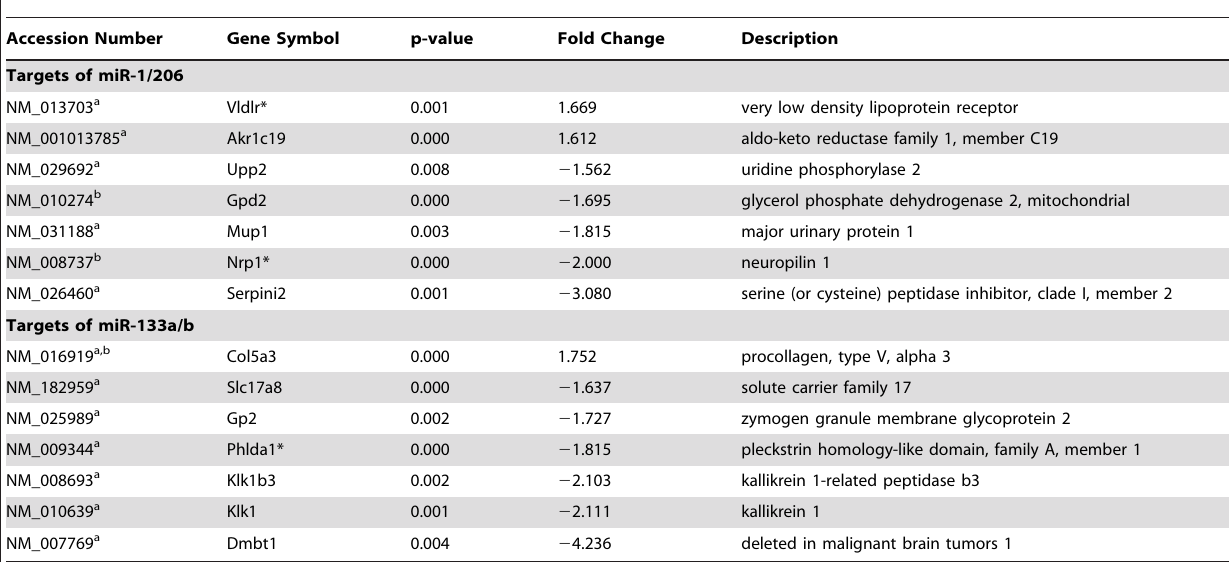
Table 3. Targets of miRs-1, 206, 133a and 133bthat were significantly altered in hypothyroid mouse liver (p , 0.05, Fold change . 1.5).